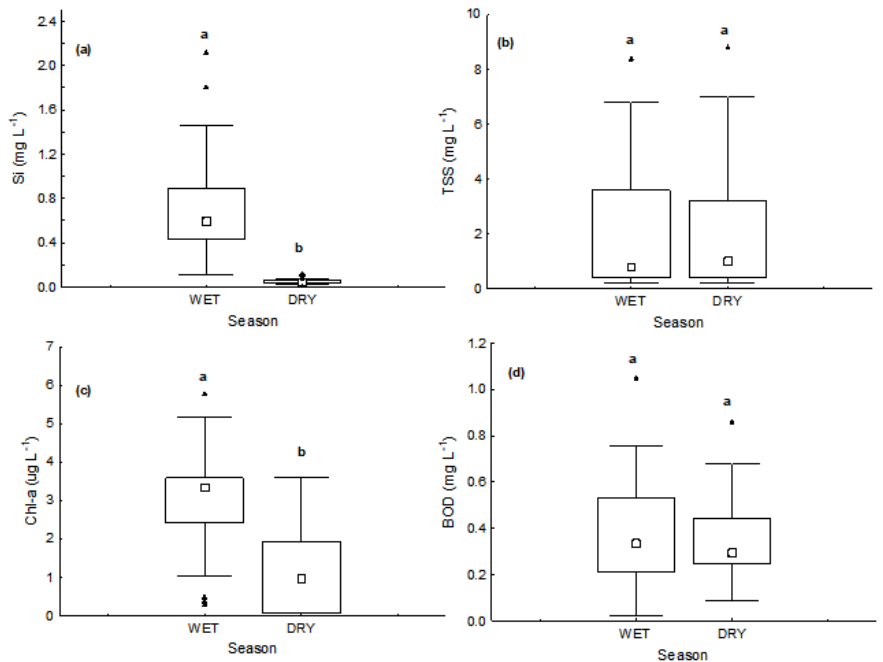
Figure 6. Box and whisker plots of seasonal variation of water quality variables: ( a ) Si, ( b ) TSS, ( c ) Chl-a, and ( d ) BOD 5 . Small white square represents median values, boxes represent the interquartile range, range bars show the maximum and minimum values, black triangles represent the extremes and black diamonds show the outliers. Different letters (a and b) over box plots indicate a significant difference (Mann-Whitney U test, p < 0.05).